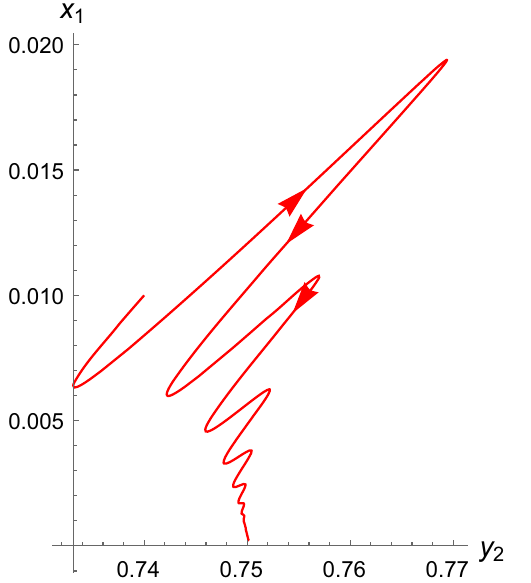
Fig. 8 The evolution towards P 8 critical point ( ξ 1 = 0 . 5 ,ξ 2 = 10 ,α 1 = 30 ,α 2 = 3 ,w m =